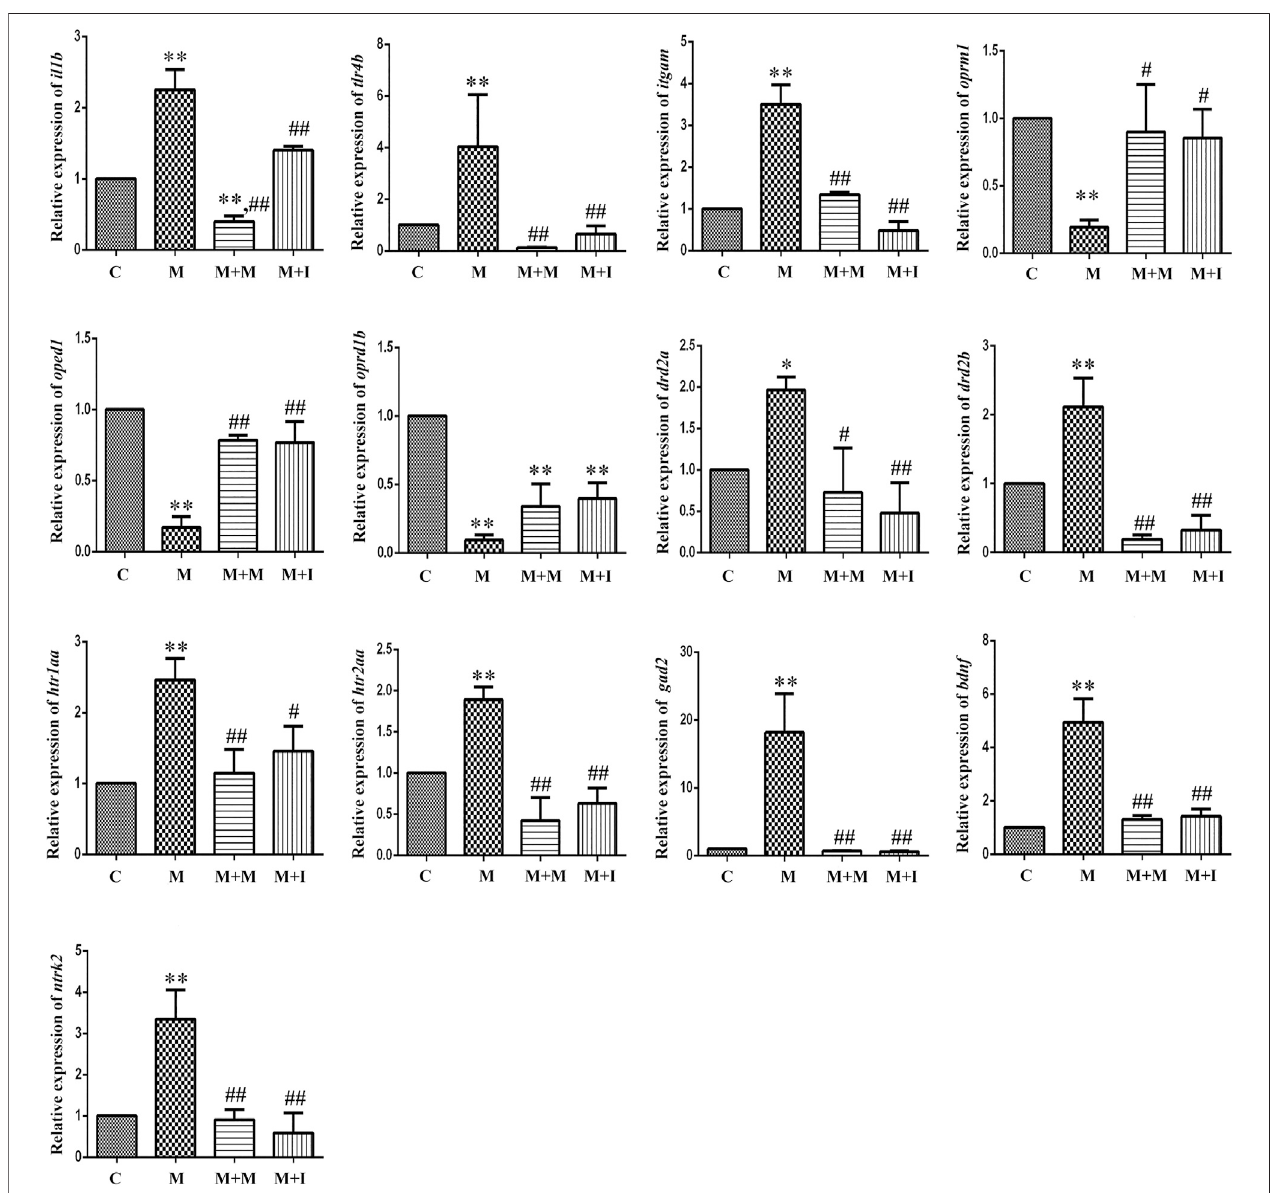
FIGURE 9 | qPCR analysis of il1b , tlr4b , itgam , oprm1 , oprd1 , oprd1b , gad2 , drd2a , drd2b , htr1aa , htr2aa , bdnf , and ntrk2 expression in the zebra fi sh gut ( n (cid:2) 3). * p < 0.05,** p < 0.01 vs theCgroup; # p < 0.05, ## p < 0.01 vs theMgroup.C:controlgroup;M:morphinegroup;M+M:morphine+methadonegroup;M+I:morphine+ isorhynchophylline